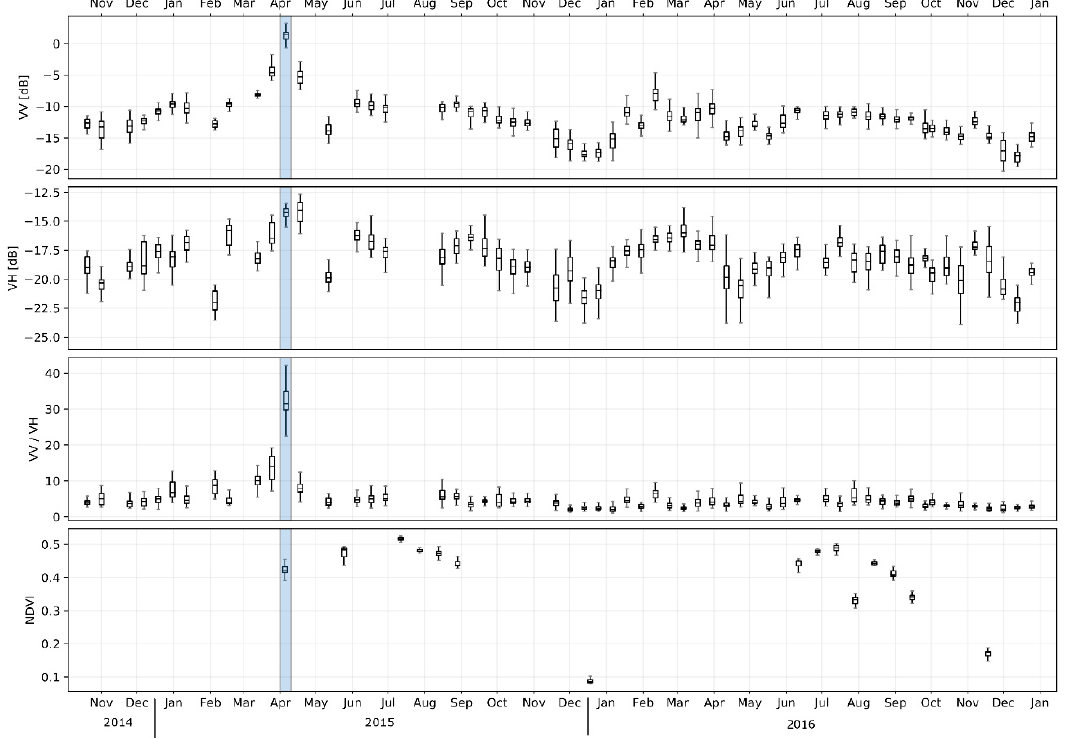
Figure 7. Multitemporal behavior of the backscatter intensity for TFV areas for VV (dB), VH (dB), VV/VH (linear scale), and NDVI values in southern Greece/Turkey. The blue bars mark the analyzed date at the flood event.